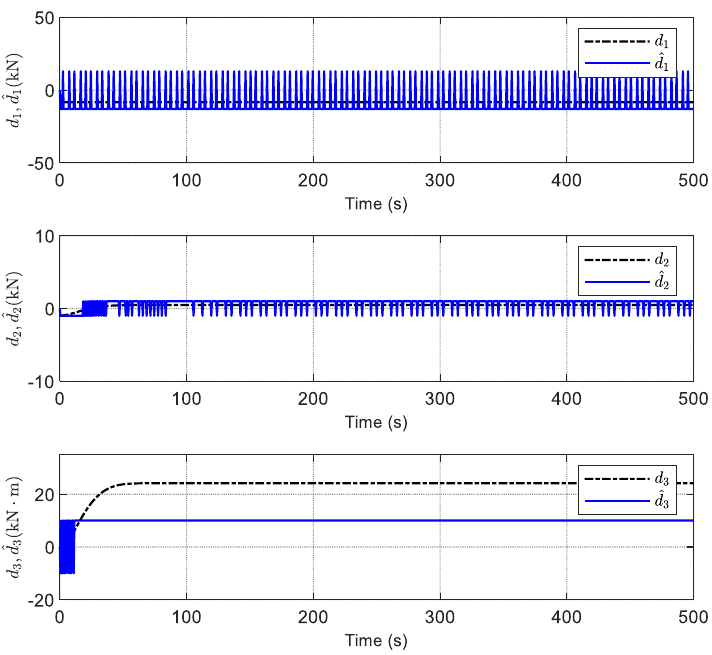
Figure 11. Estimation of disturbances via SMDO.